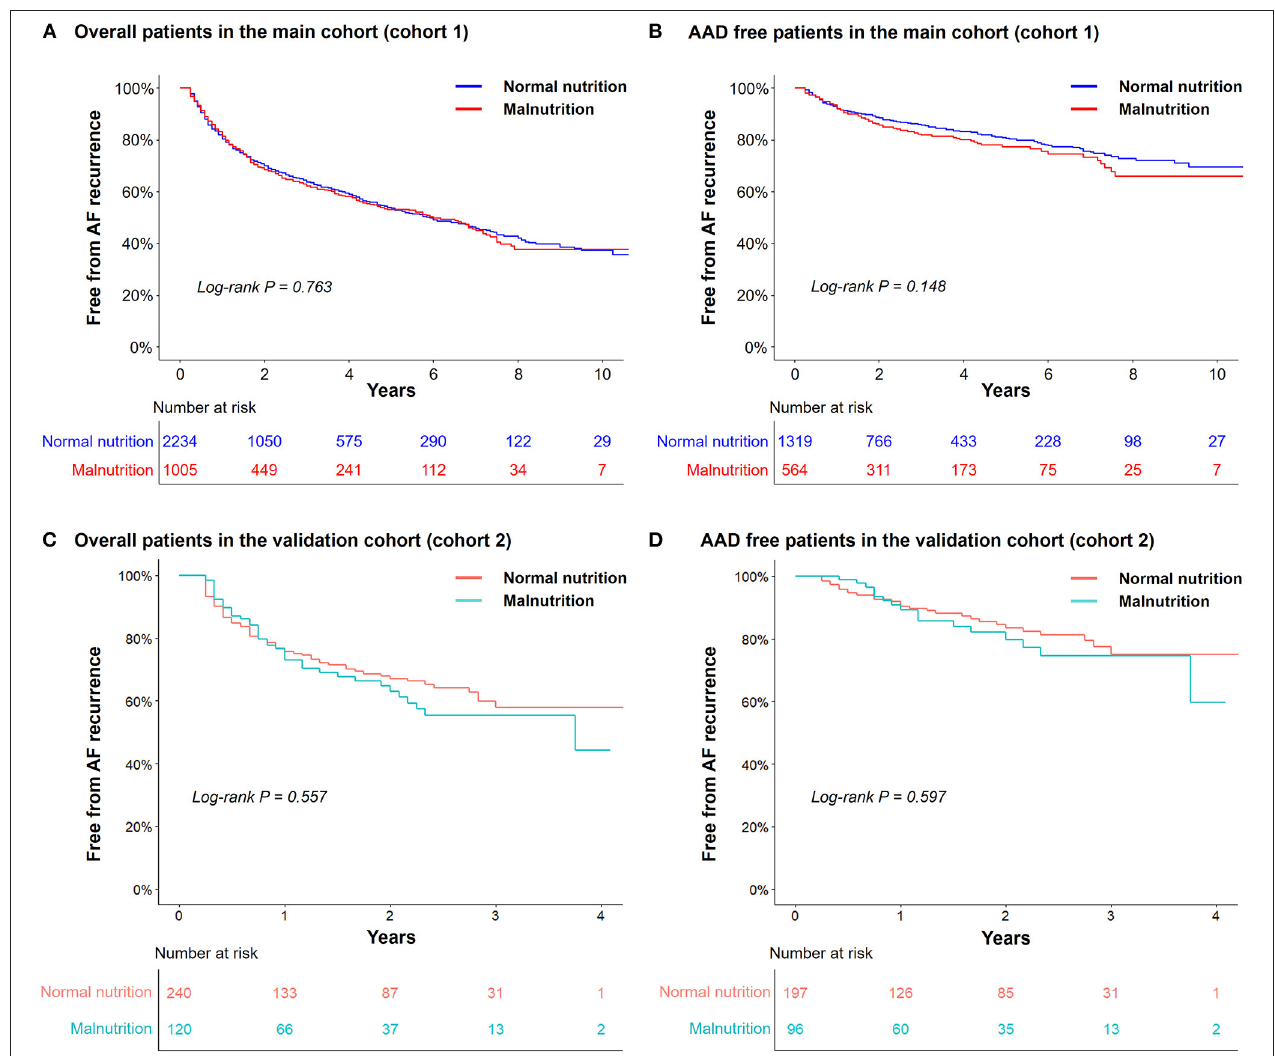
FIGURE 3 | Kaplan–Meier analyses of the atrial fibrillation (AF) recurrence-free survival rate in the cohort 1 (the main cohort) ( n = 3,239; A,B ) and in the cohort 2 (the external validation cohort) ( n = 360, C,D ). AAD, antiarrhythmic drugs.